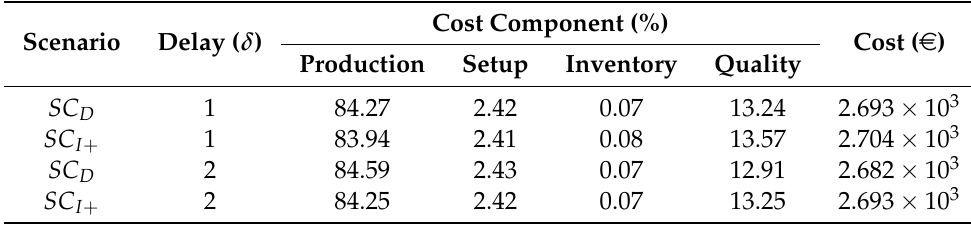
Figure 6. Optimal profiles for production and inventory levels for stochastic consumption with delayed inventory control: ( a ) Production of A, C, G; ( b ) Production of B, D, E, F, H; ( c ) Inventory of A, C, G; ( d ) Inventory of B, D, E, F, H. Table 4. Importance of cost components relative to overall optimal cost for 28d production horizon (stochastic consumption and delayed inventory